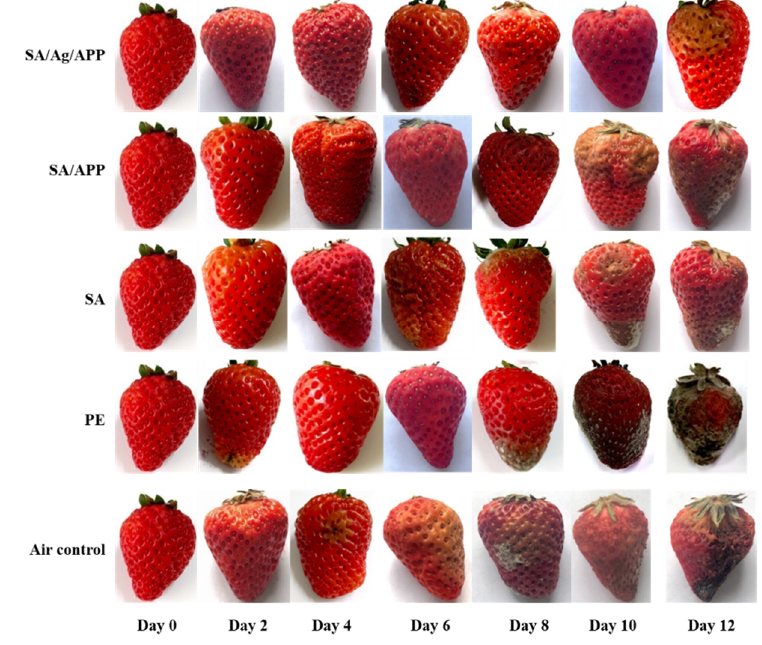
Figure 7. Picture of strawberries during 12 days of strawberry